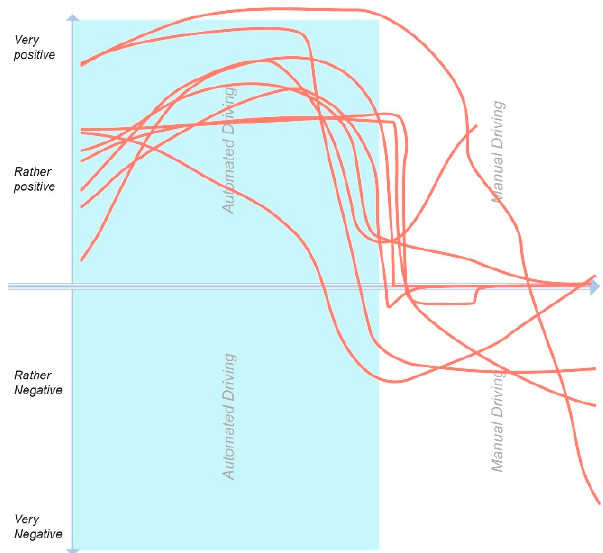
Figure 4. Curves with steep downward inclination.